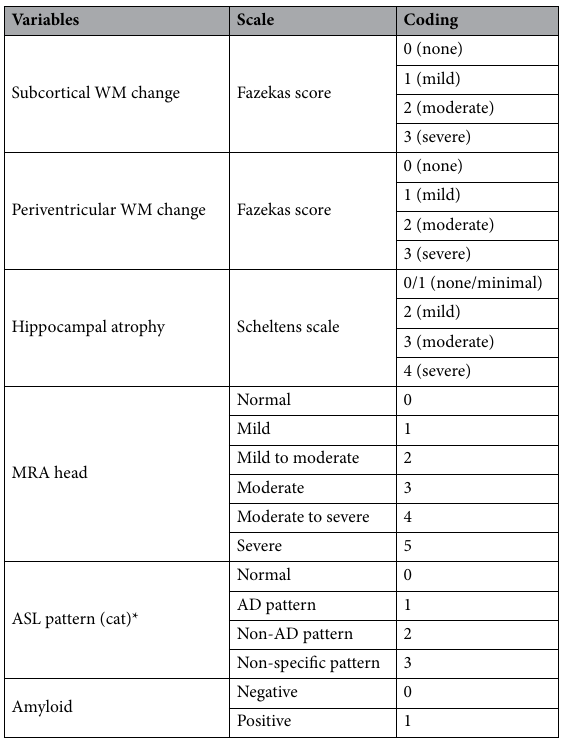
Table 2. MRI and PET variables and the codes used in logistical regression analysis. *ASL pattern was defined as categorical